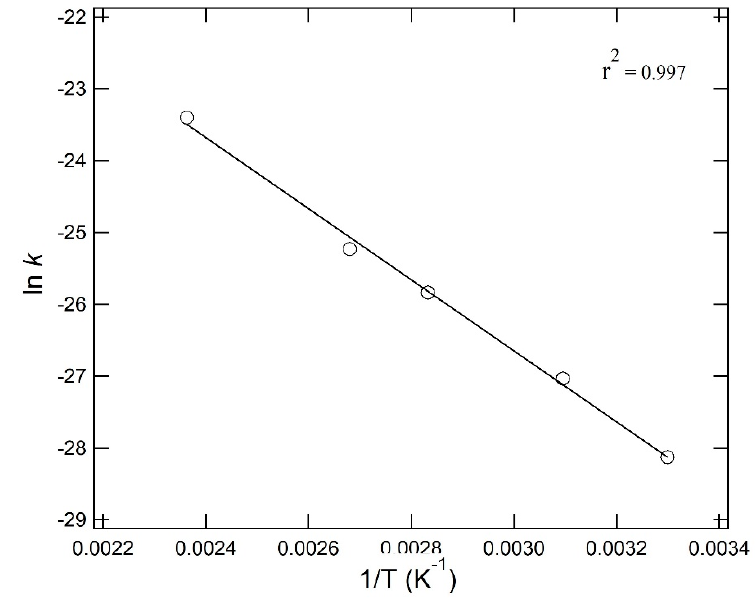
Figure 3. Arrhenius plot of styrene trimer (ST) formation through PS-decomposition at 30 to 150 °C.